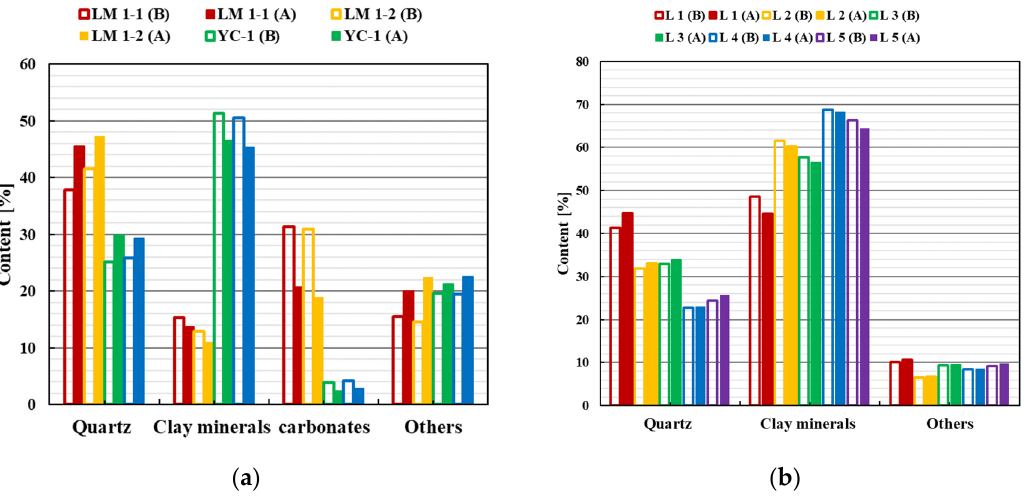
Figure 8. Mineral content of shale before ( b ) and after ( a ) shale reacted with CO 2 . ( a ) 10 d, 16 MPa, 40 °C [13]; ( b ) 6 m, 17.9 Mpa, 50 °C [28].